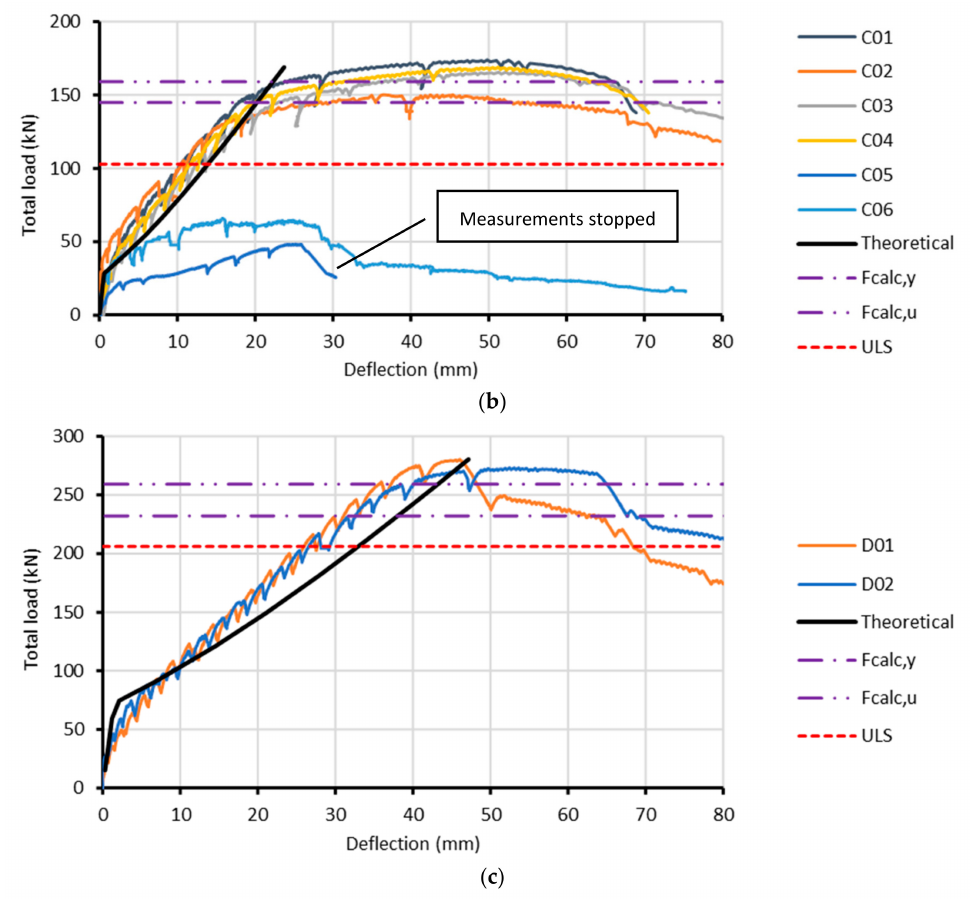
Figure 5. Measured and estimated load–deflection curves: ( a ) A-series of Airdeck tests; ( b ) C-series of solid tests; and ( c ) D-series of U-Boot